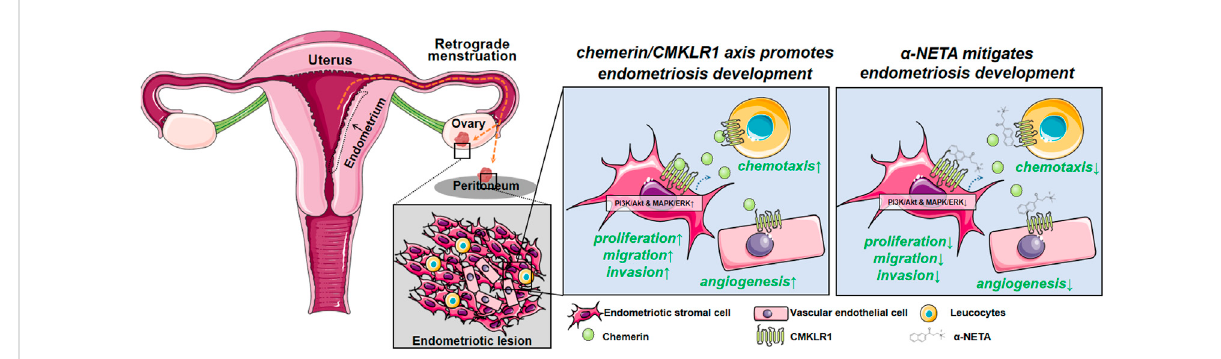
FIGURE 7 Schematic illustrating the current working model. Chemerin acts via CMKLR1 to regulate a series of biological events, thus promoting the endometriotic lesion establishment and development. Disrupting the chemerin/CMKLR1 axis by α -NETA alleviates the endometriosis